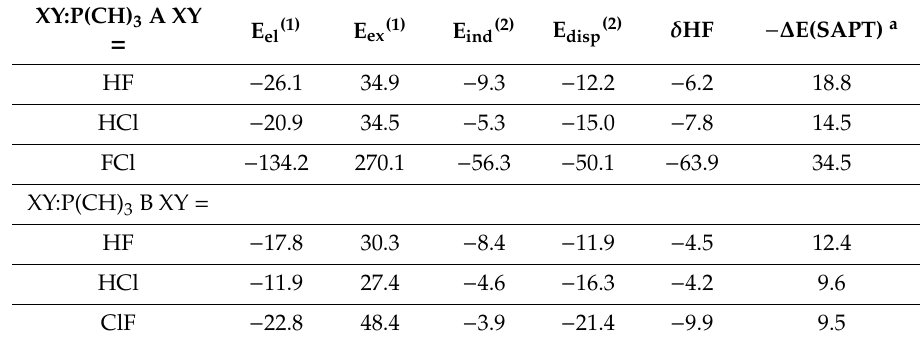
Table 3. SAPT energies (kJ mol − 1 ) for equilibrium XY:P(CH) 3 complexes isomers A and B